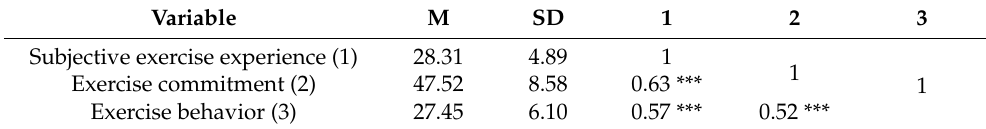
Table 3. Correlation of the subjective exercise experience, exercise commitment, and exercise behavior. Variable